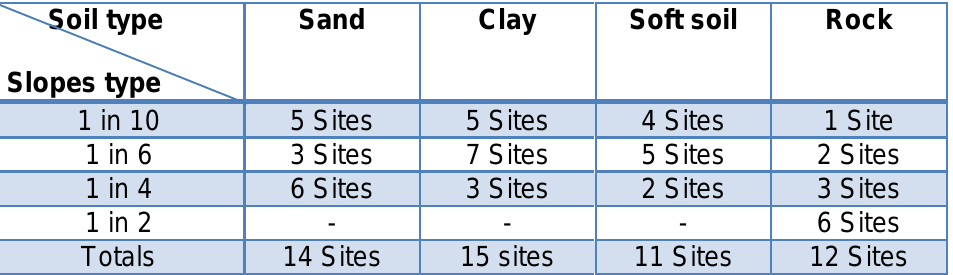
Table 1: Summary of projects by soil and slopes type Soil